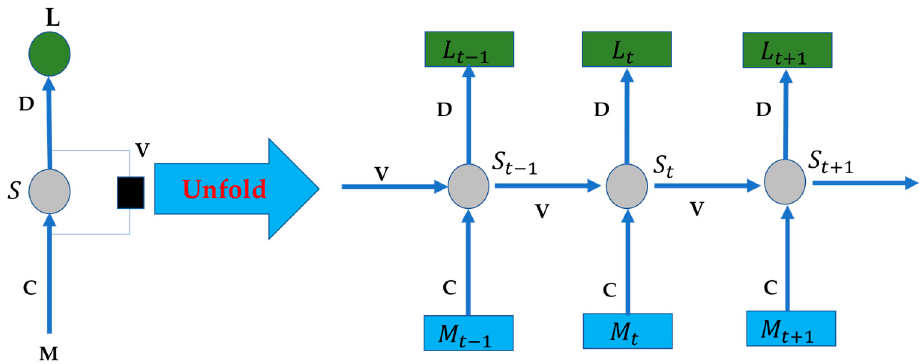
Figure 4. A typical RNN structure in the unrolled (network of entire sequence) form of a completely linked network